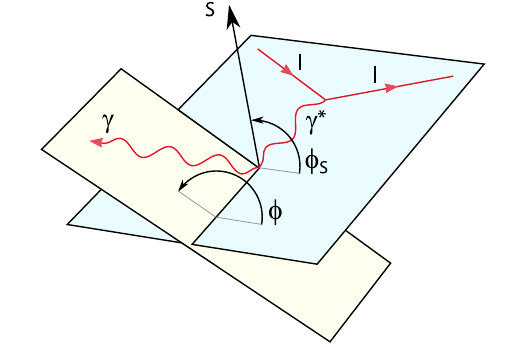
Fig. 2 KinematicsofDVCSinthetargetrestframe.Theanglebetween the leptonic plane (spanned by the incoming and outgoing lepton momenta) and the production plane (spanned by the virtual and outgo- ing photon momenta) is denoted by φ . The angle between the leptonic plane and the nucleon polarization vector is denoted by φ S